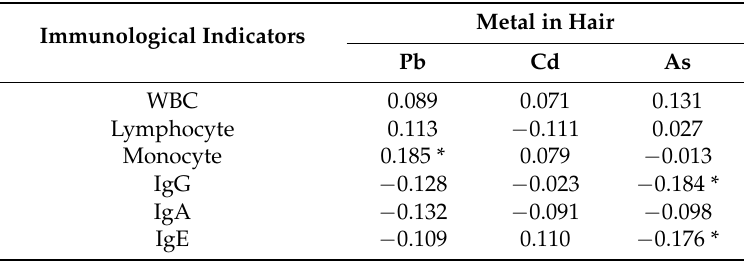
Table 4. Spearman’s correlation between immunological indicators in blood samples and arsenic, cadmium and lead levels in hair